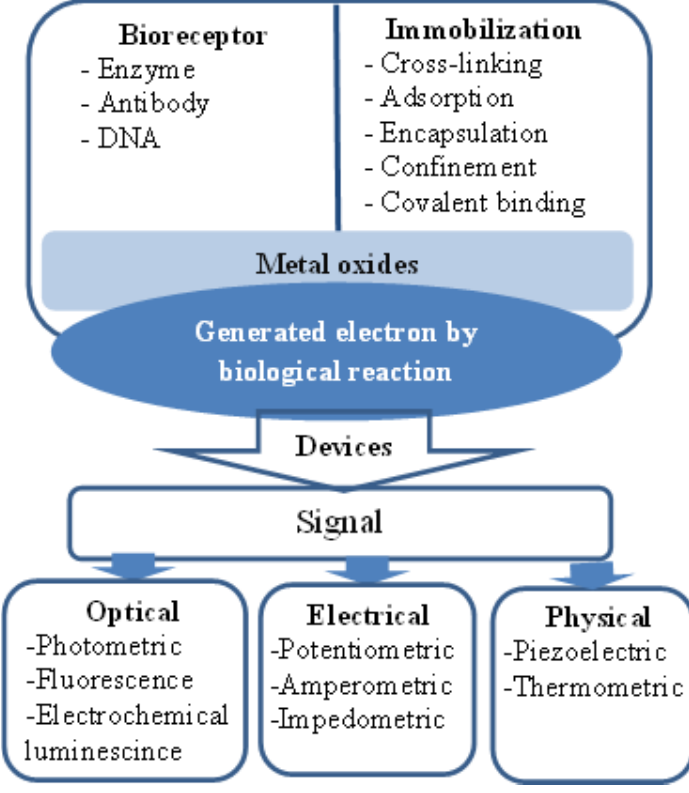
Figure 1. Schematic diagram for metal oxide nanostructure-based biosensing